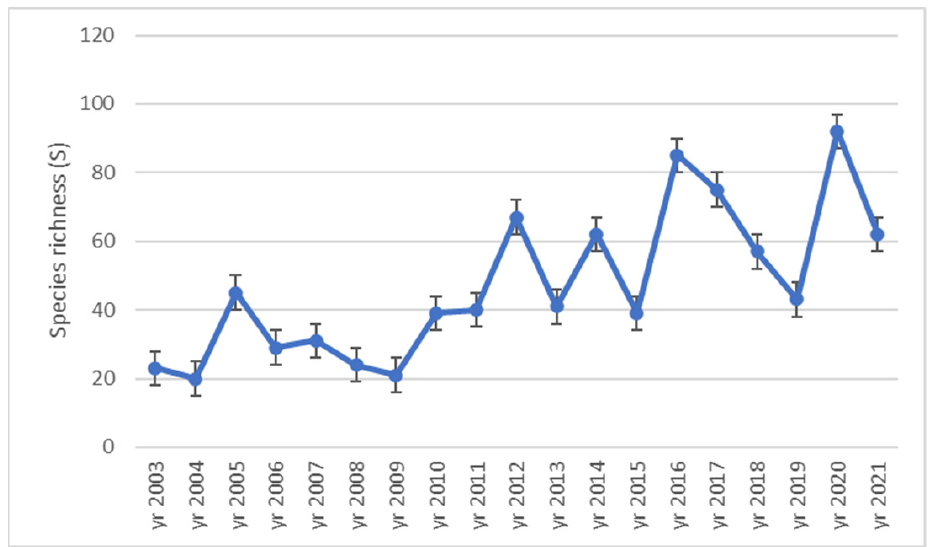
Figure 3. Dynamics of species richness (S) during 2003–2021 time interval in ex-arable grassland from Gr ă dinari (standard error displayed).